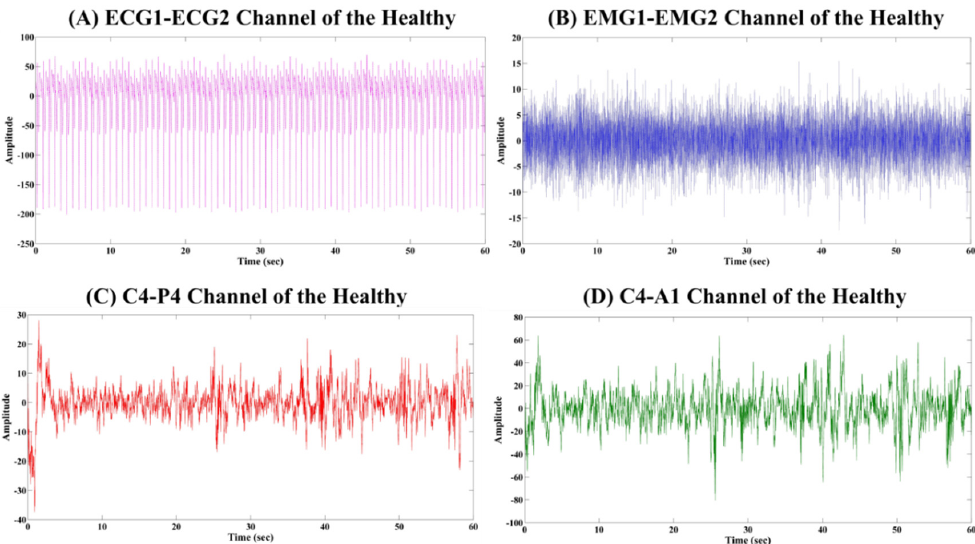
Figure4. Signalrepresentationofthesixty-secondsleepsphysiologicalchannelssuchas( A )ECG1-ECG2, Figure 4. Signal representation of the sixty-second sleeps physiological channels such as ( A ) ECG1- ( B ) EMG1-EMG2, ( C ) C4-P4, and ( D ) C4-A1 of the healthy subjects. A 10 / 20 standard sleep recording ECG2, ( B ) EMG1-EMG2, ( C ) C4-P4, and ( D ) C4-A1 of the healthy subjects. A 10/20 standard sleep recording system recorded them. system recorded